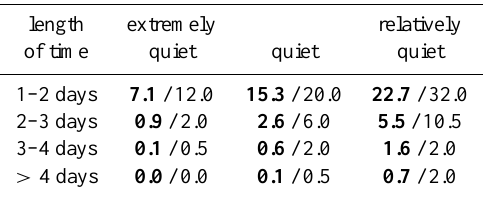
Table 1. Yearly occurrence frequency of different lengths of quiet periods. Bold numbers are for the entire K p database (1932–2000) and non-bold refer to the two-year period during solar